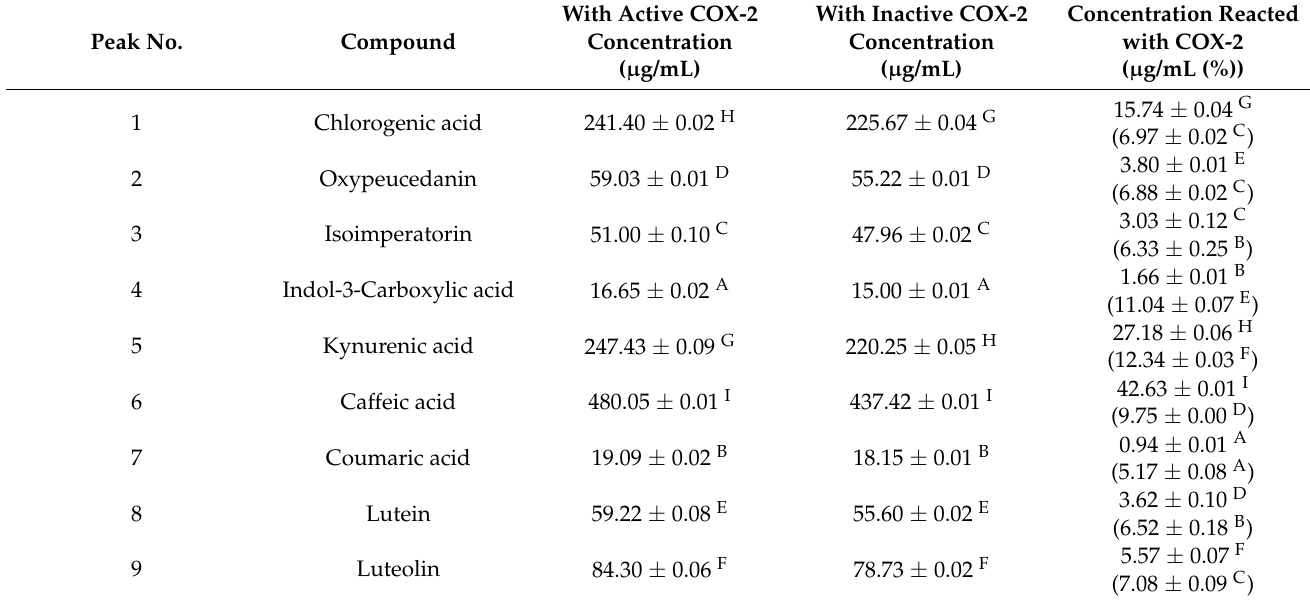
Table 4. Screening of COX-2 ligands of the polyphenol compounds in Gynura procumbens .